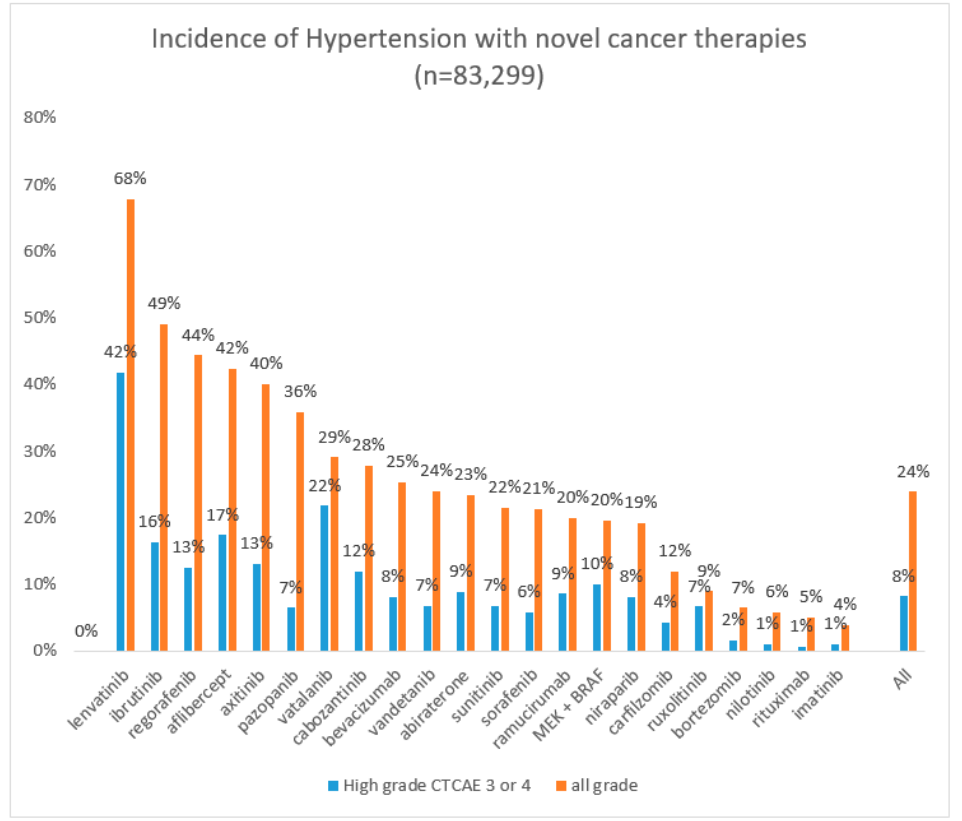
Figure 3. Graph showing incidence of hypertensive cardiotoxicity (high grade versus all grade) with various novel cancer therapies. Incidence is ordered from highest to lowest for all grade hypertension; the bar for all is a weighted average calculation across all novel drug types in our analysis.